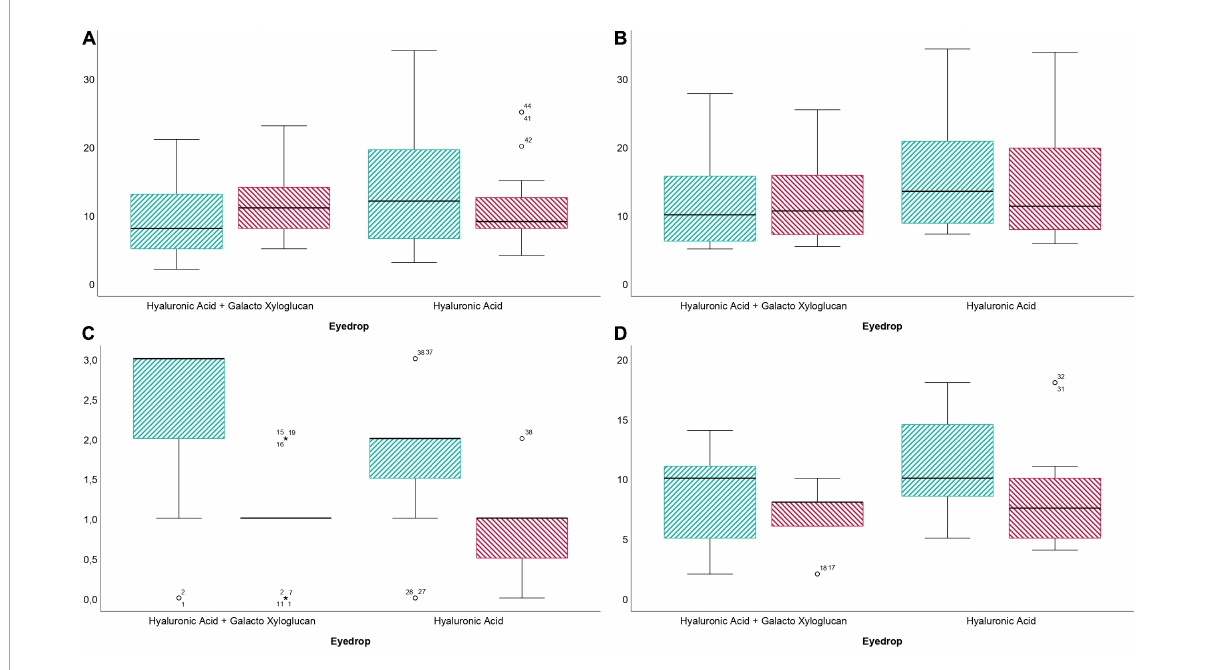
FIGURE2 Box and plot graph differences before and after treatment with 0.40% hyaluronic acid with 0.20% galacto-xyloglucan (HA-GX) and 0.40% hyaluronic acid (HA). (A) Break up time differences before (striped, green) and after (striped, red) eyedrop treatment. (B) Mean non-invasive break-up time (NIBUT) before (striped, green) and after (striped, red) eyedrop treatment. (C) Conjunctival redness before (striped, green) and after (striped, red) eyedrop treatment and (D) . Standard patient evaluation eye disease (SPEED) before (striped, green) and after (striped, red) eyedrop